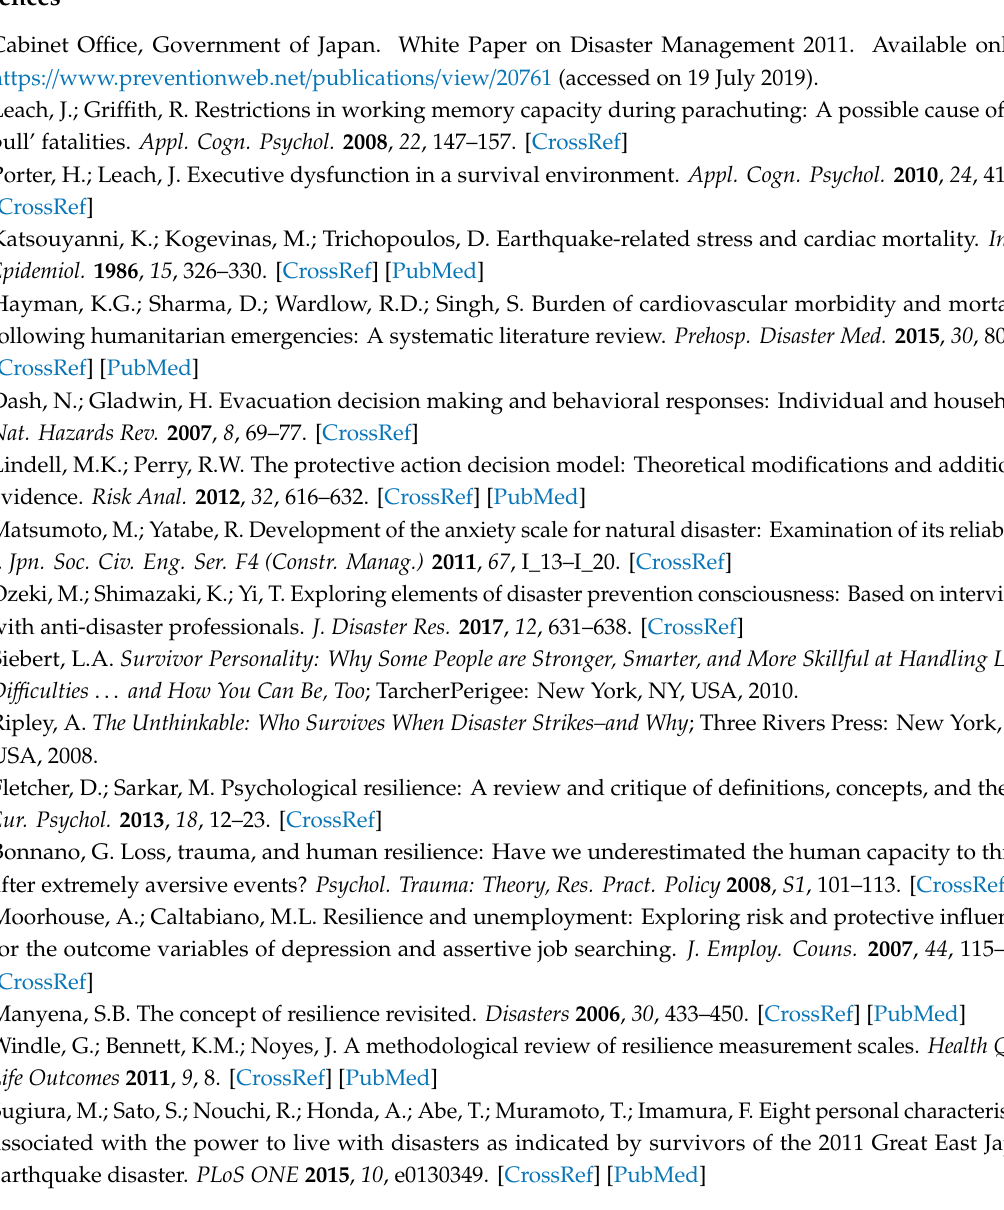
Table S1: The original 34 questions in the full power-to-live questionnaire; Table S2: Questions to acquire the five survival indices; Table S3: Mean scores of the eight Power to Live factors in the survivors of 2011 earthquake; Table S4: Mean scores of the eight Power to Live factors in the normative population. Supplementary data: Raw responses from normative population to Power to Live and Big Five